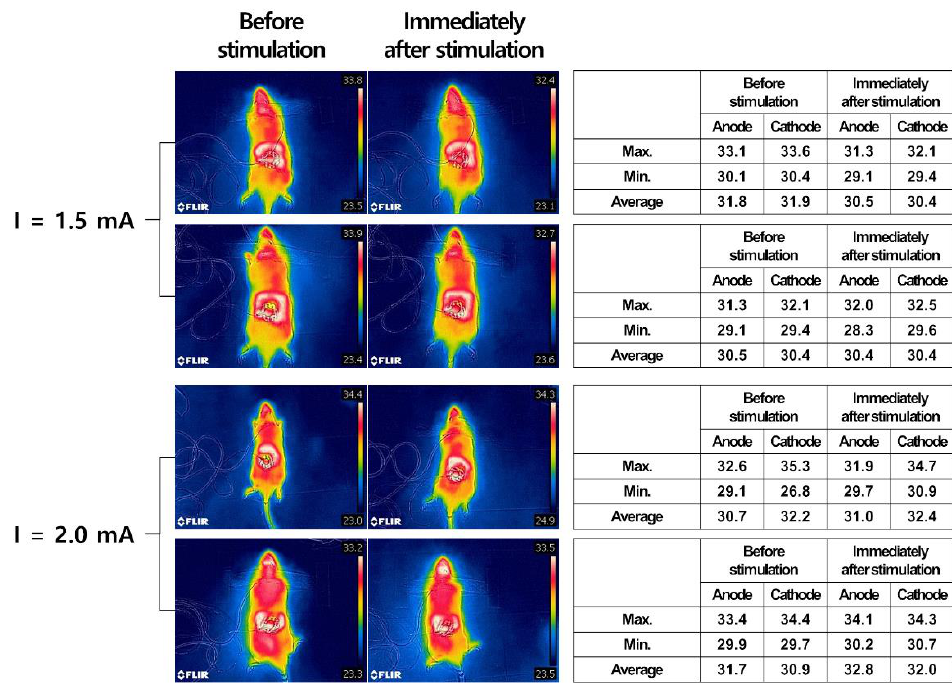
Figure 6. Thermal images of rats measured before and immediately after 20 min applications of 10 Hz tACS with an electrical current of 1.5 or 2.0 mA. Regions where an anode or a cathode was located on the heads and backs of rats had higher temperatures than other regions, but the temperature did not increase above 41 ◦ C even after 20 min of tACS. The average, the maximum, and the minimum temperatures of regions where the anode and the cathode were attached are described on the right side of the thermal